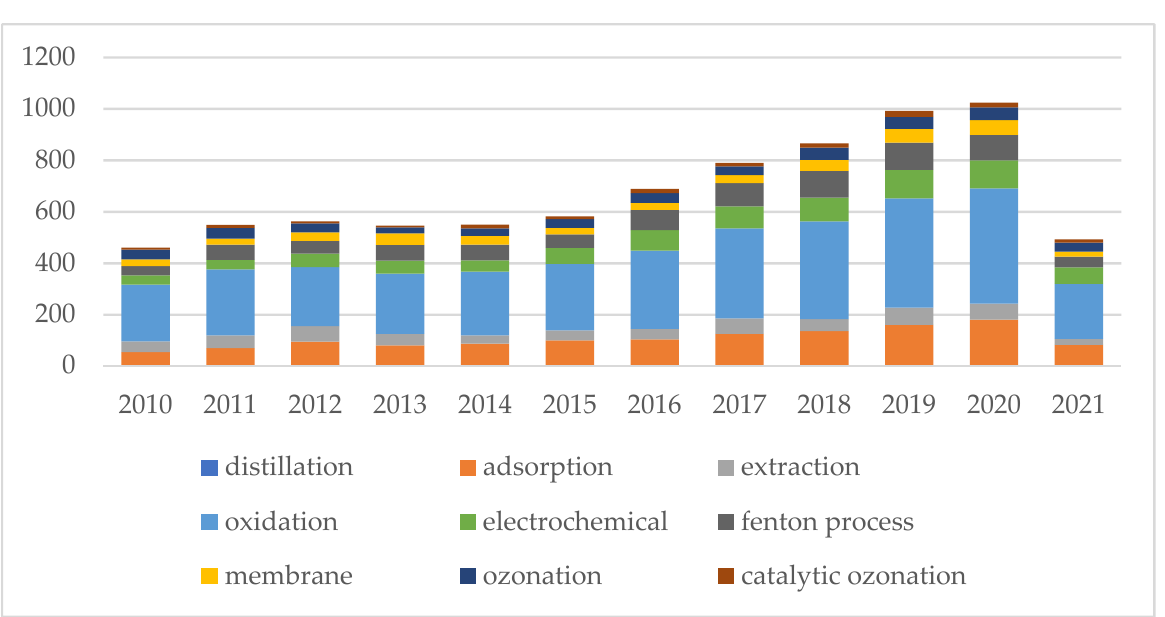
Figure 2. The number of annual publications related to various methods to degrade phenol in 2010–2021. Indexed by Scopus (TITLE-ABS-KEY (terms); terms: distillation, adsorption, extraction, oxidation, electrochemical, Fenton process, membrane, ozonation, catalytic ozonation phenol degradation) [10].